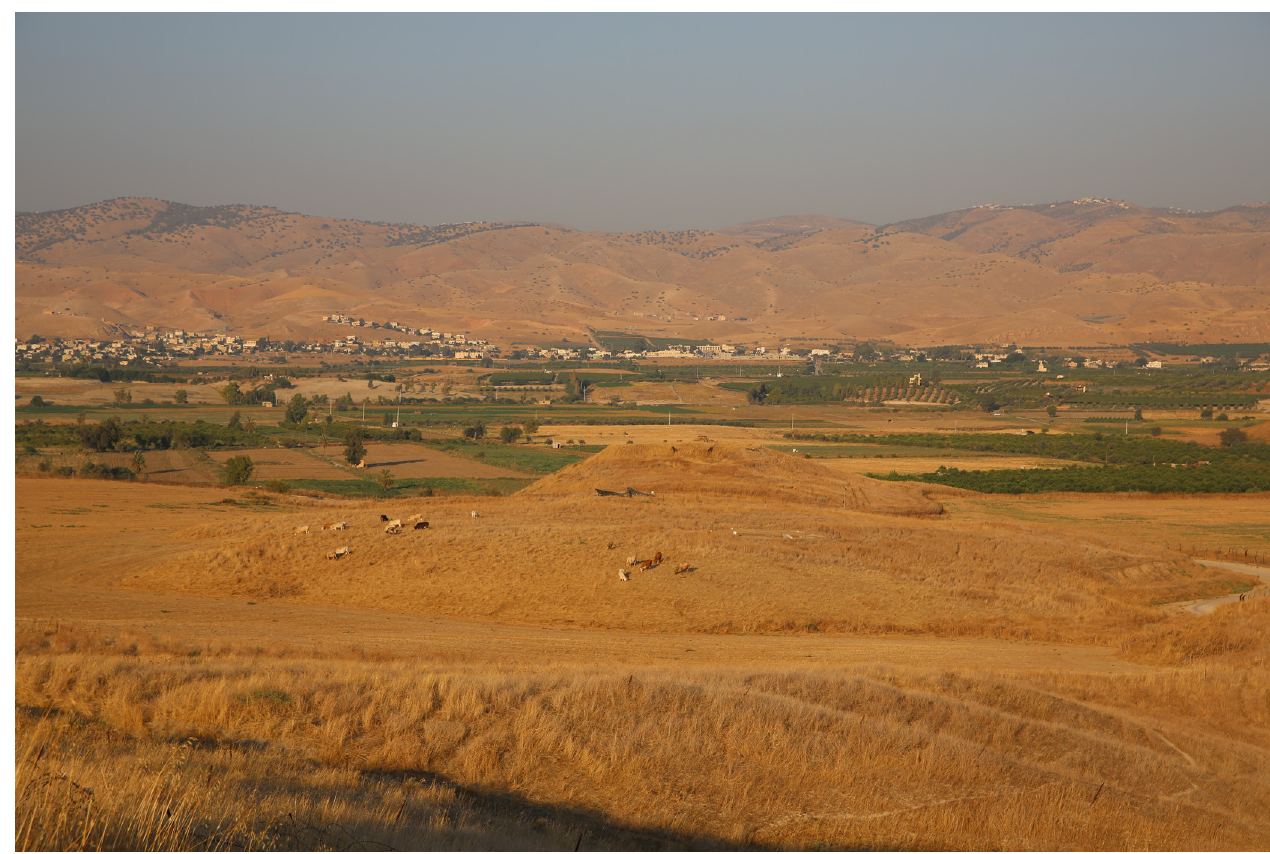
Fig 2. Tel Tsaf. A view from the